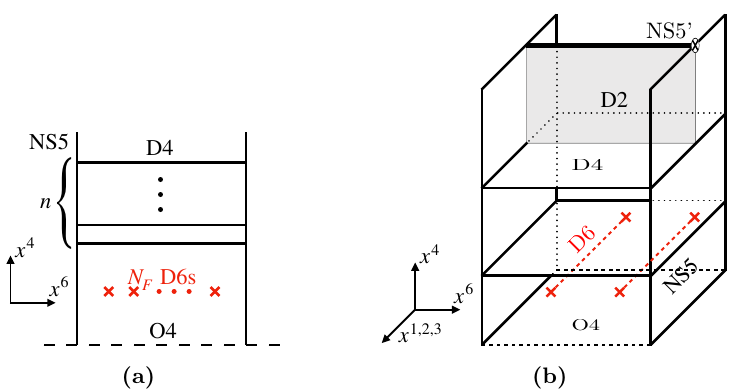
Figure 3. (a): a brane construction of the SO / USp SQCD with an O4-plane. The ( x 4 , x 6 ) - directions are shown explicitly, and the mirror image is omitted. (b): the brane configuration for the SQCD with n = N F = 2 . In addition to the ( x 4 , x 6 ) -directions of figure 3a, another direction that collectively represents ( x 1 , x 2 , x 3 ) is added to the figure. A D2-brane with an NS5’-brane realizing the minimal ’t Hooft operator is also